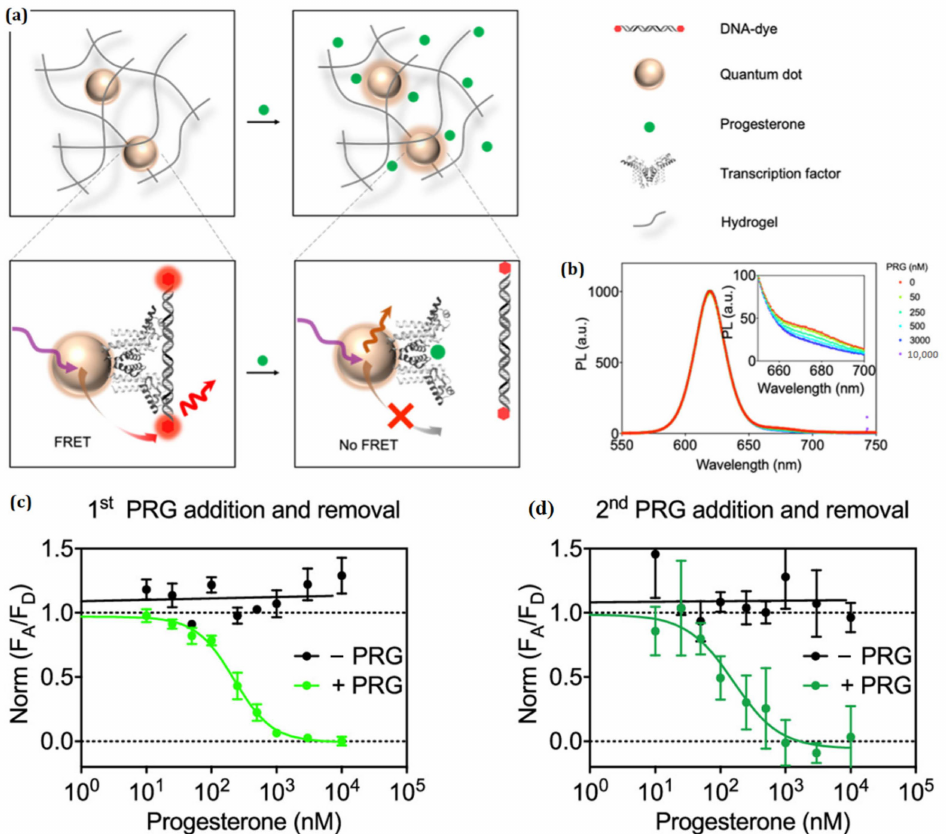
Figure 9. ( a ) FRET sensor that is based on QDs and is immobilized in the hydrogel. An image of a schematic depicting the diffusion of progesterone into the hydrogel and FRET-based sensor utilizing the TF–DNA binding mechanism, ( b ) Representative spectra of sensor response to progesterone. ( c ) the first cycle of progesterone (PRG) exposure and removal, the sensor exhibited a response. ( d ) The second cycle of progesterone exposure and removal elicits a sensor response when exposed to progesterone on a regular basis. Reproduced with permission from ref. [117] © 2023 American Chemical